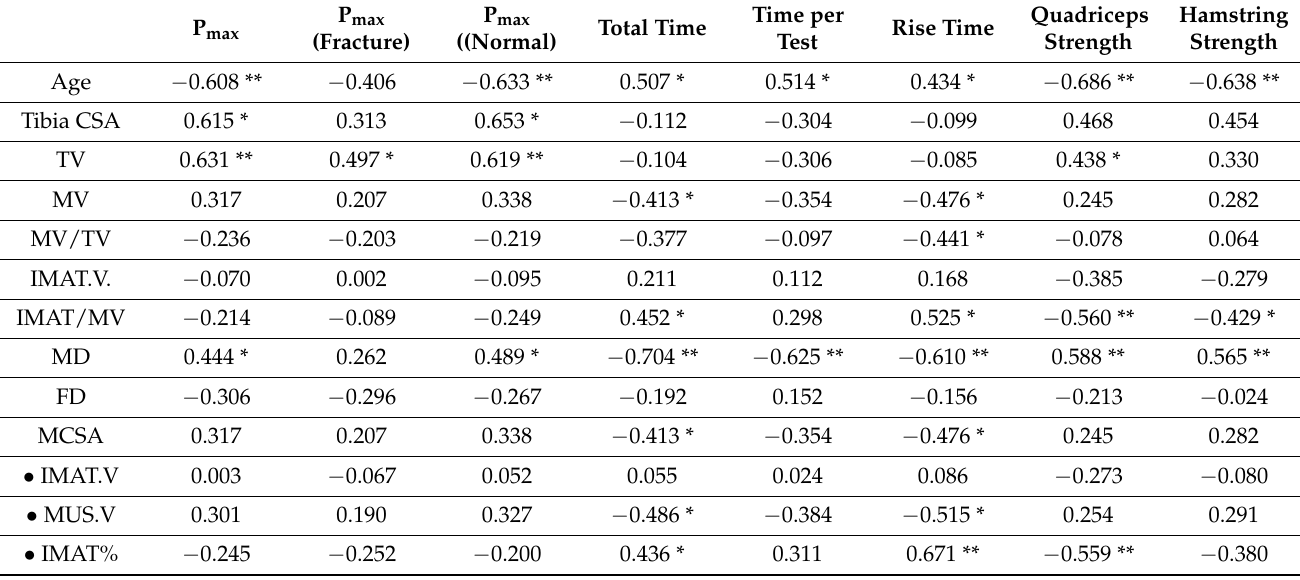
Table 2. Correlations between various muscle-related parameters produced by HR-pQCT and functional parameters of the